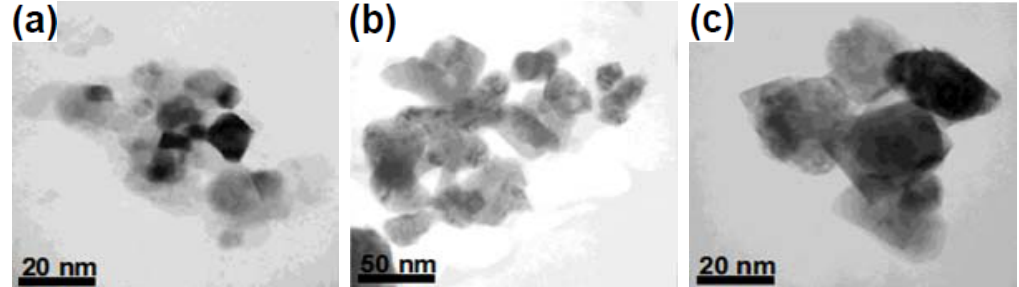
Figure 5. TEM images of the 1.0 mol% Er 3+ -doped BaTiO 3 nanoparticles obtained after heating to three different temperatures: ( a ) 700 °C; ( b ) 850 °C; and ( c ) 1000 °C. Reproduced from [71]. Copyright 2003, American Chemical Society.